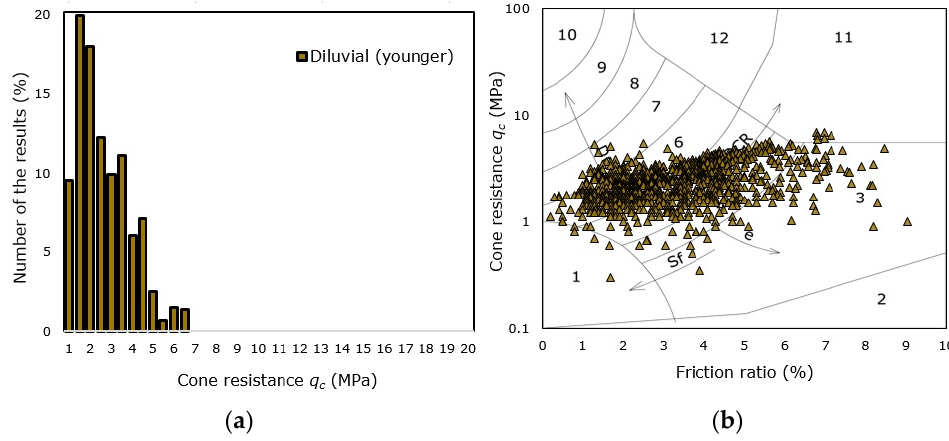
Figure 5. Summary of results for the diluvial facies ( a ) distribution of q c values ( b ) sounding parameters plotted against Robertson’s chart (1—sensitive fine grained; 2—organic material; 3—clay; 4—silty clay to clay; 5—clayey silt to silty clay; 6—sandy silt to clayey silt; 7—silty sand to sandy silt; 8—sand to silty sand; 9—sand; 10—gravely sand to sand; 11—very silty fine grained; 12—sand to clayey sand; D r —density ratio; OCR—overconsolidation ratio; Sf—sensitivity factor; e—void ratio).